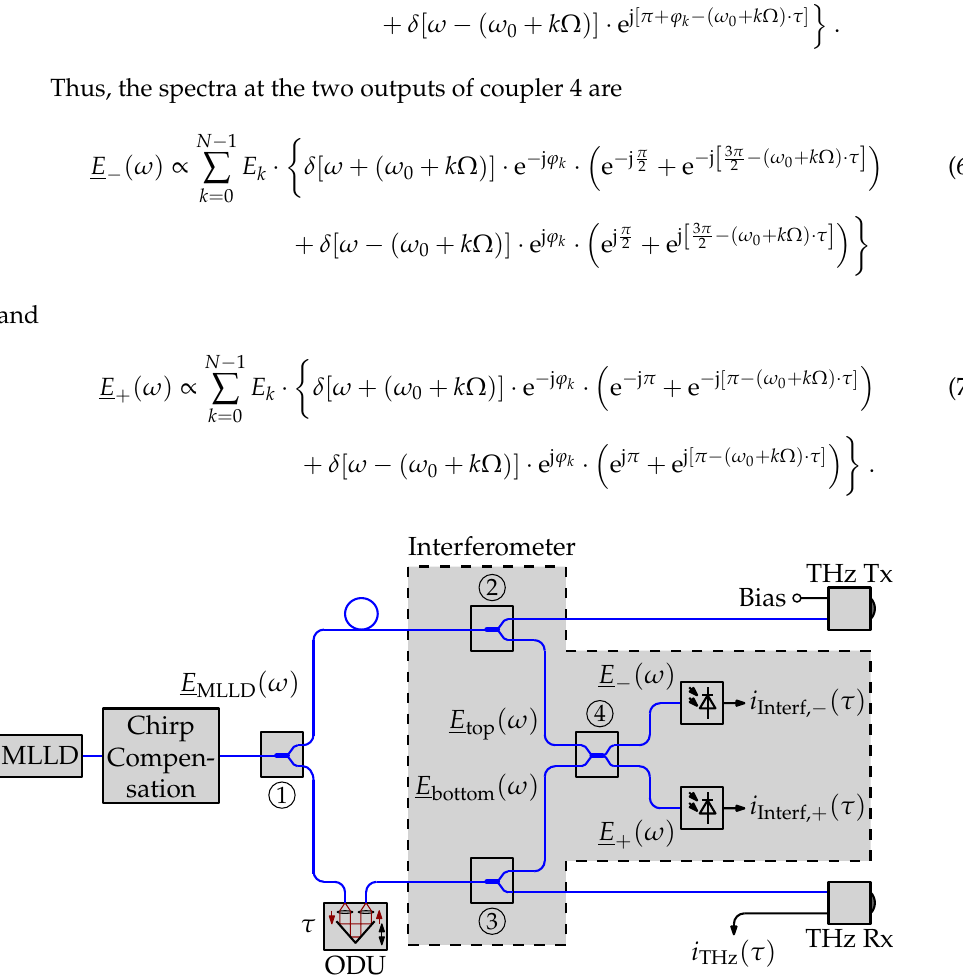
Figure 2. Simplified block diagram of a UHRR-THz-TDS system with interferometer for time synchronization. Blue lines indicate polarization maintaining fibers. Black lines indicate electrical connections. Note the numbering of the optical couplers as used in the